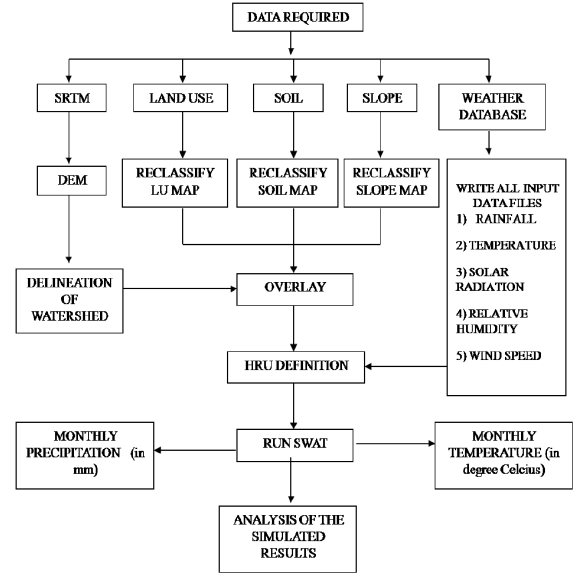
Figure 1. Study area